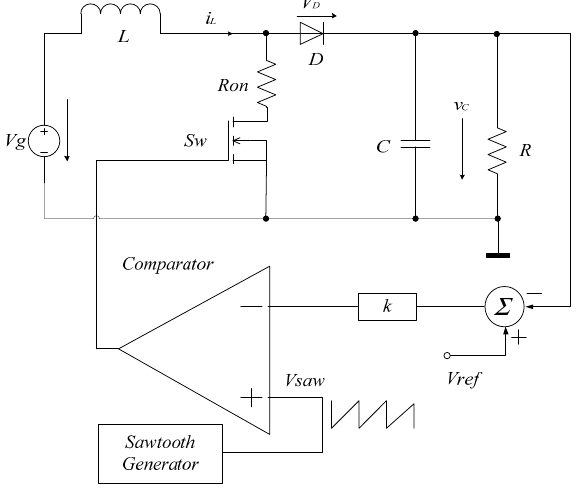
Figure 2. Proportional voltage-mode controlled boost converter.